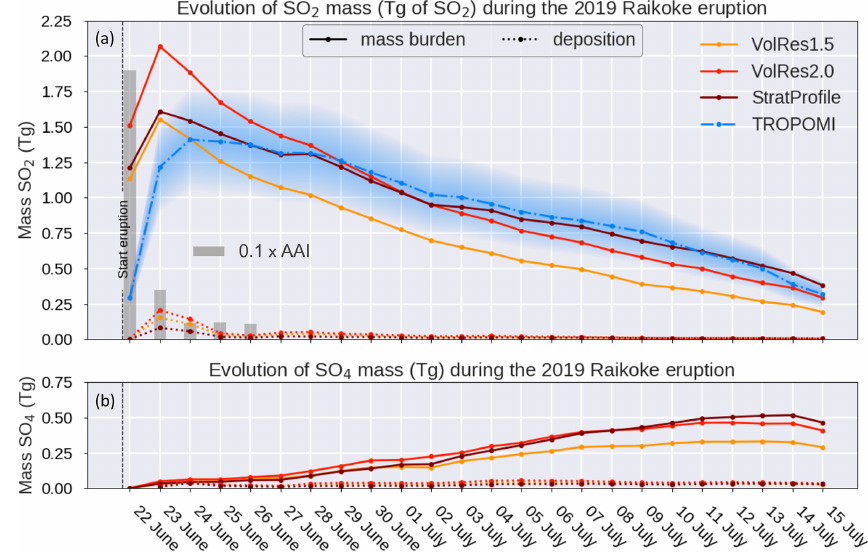
Figure 11. The daily evolution of (a) the total SO 2 mass (Tg of SO 2 ) and (b) the total SO 4 mass (Tg of SO 4 ) for the 2019 Raikoke eruption for different ESPs in NAME. We have included the TROPOMI SO 2 mass estimate (blue dashed line) as well as the evolution of three NAME runs: VolRes1.5, VolRes2.0 and StratProfile (see Fig. 2). The dotted lines in the figures show the corresponding daily deposition of SO 2 and SO 4 from the simulations. The peak values in the NAME SO 2 mass distribution are slightly higher than the mentioned total emission values in Table 2, which is the result from applying the 15km AKs to the dispersion model data. The total SO 2 mass burden for TROPOMI is calculated using all locations where the vertical column densities are above 0.3DU, while for the NAME simulations we include all mass. The blue shading represents the standard error estimate for the TROPOMI product. The grey bars show the TROPOMI estimated 0.1 × max(AAI) value inside the volcanic cloud for the first 5d after the eruption. The high AAI values during the first 48h indicate high concentrations of ash, thereby affecting the TROPOMI SO 2 retrievals during this